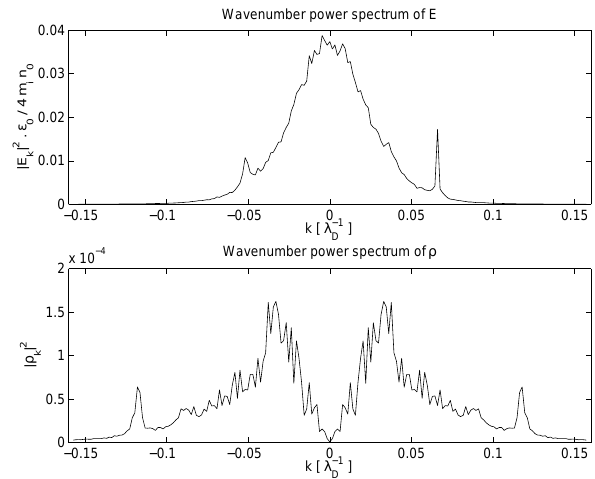
Fig. 3. Wave number power spectrum of demodulated complex electric field (in dimensionless units) and of normalized density fluctuations. The Nyquist wave number is 0 . 4 λ − 1 D